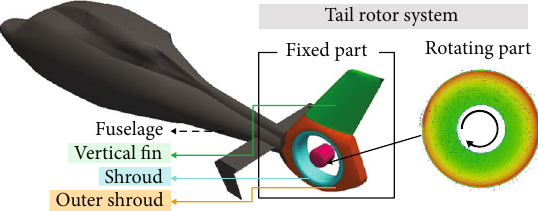
Figure 2: De fi nition of each part of the con fi